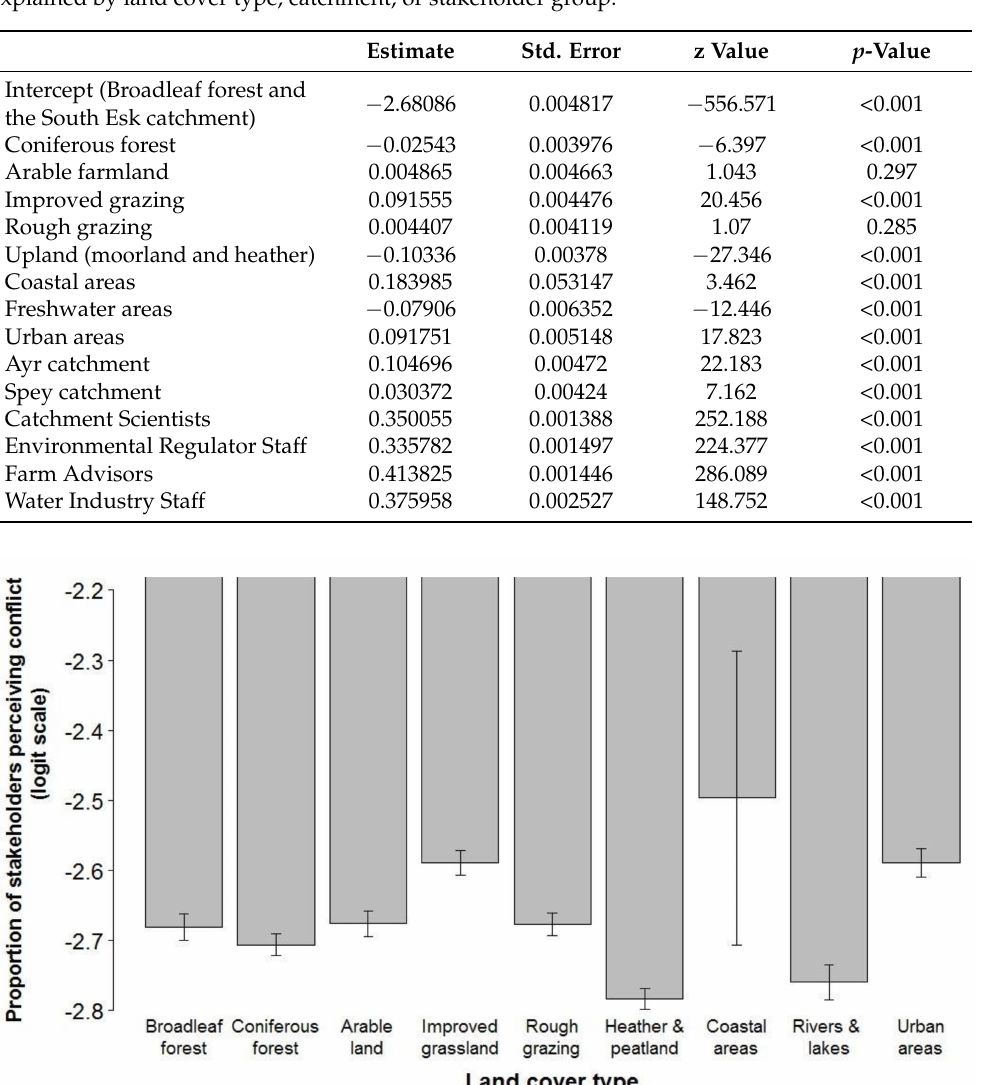
Figure 5. Difference between the binomial GLM coefficients, modelling how different land cover types may explain perceived conflict in the South Esk catchment (logit scale, ± standard error). The greater the coefficient (closer to 0), the better a land cover type predicts areas with greater perceived conflict in the